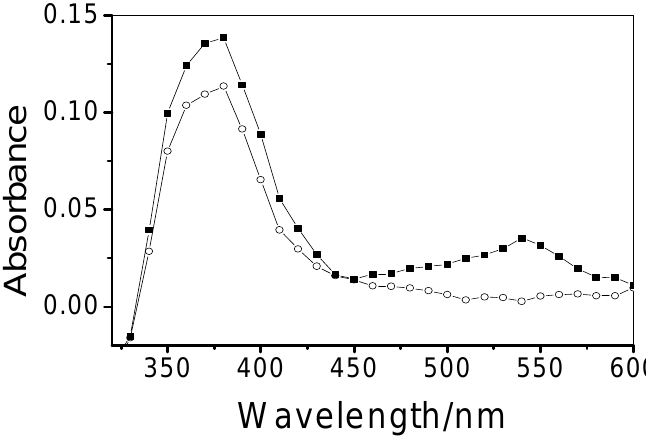
Figure 2. Transient absorption spectra of AQ recorded at 3 µ s after 355 nm laser excitation in DMF solution containing 1 · 10 -4 mol (cid:215) dm -3 AQ under N